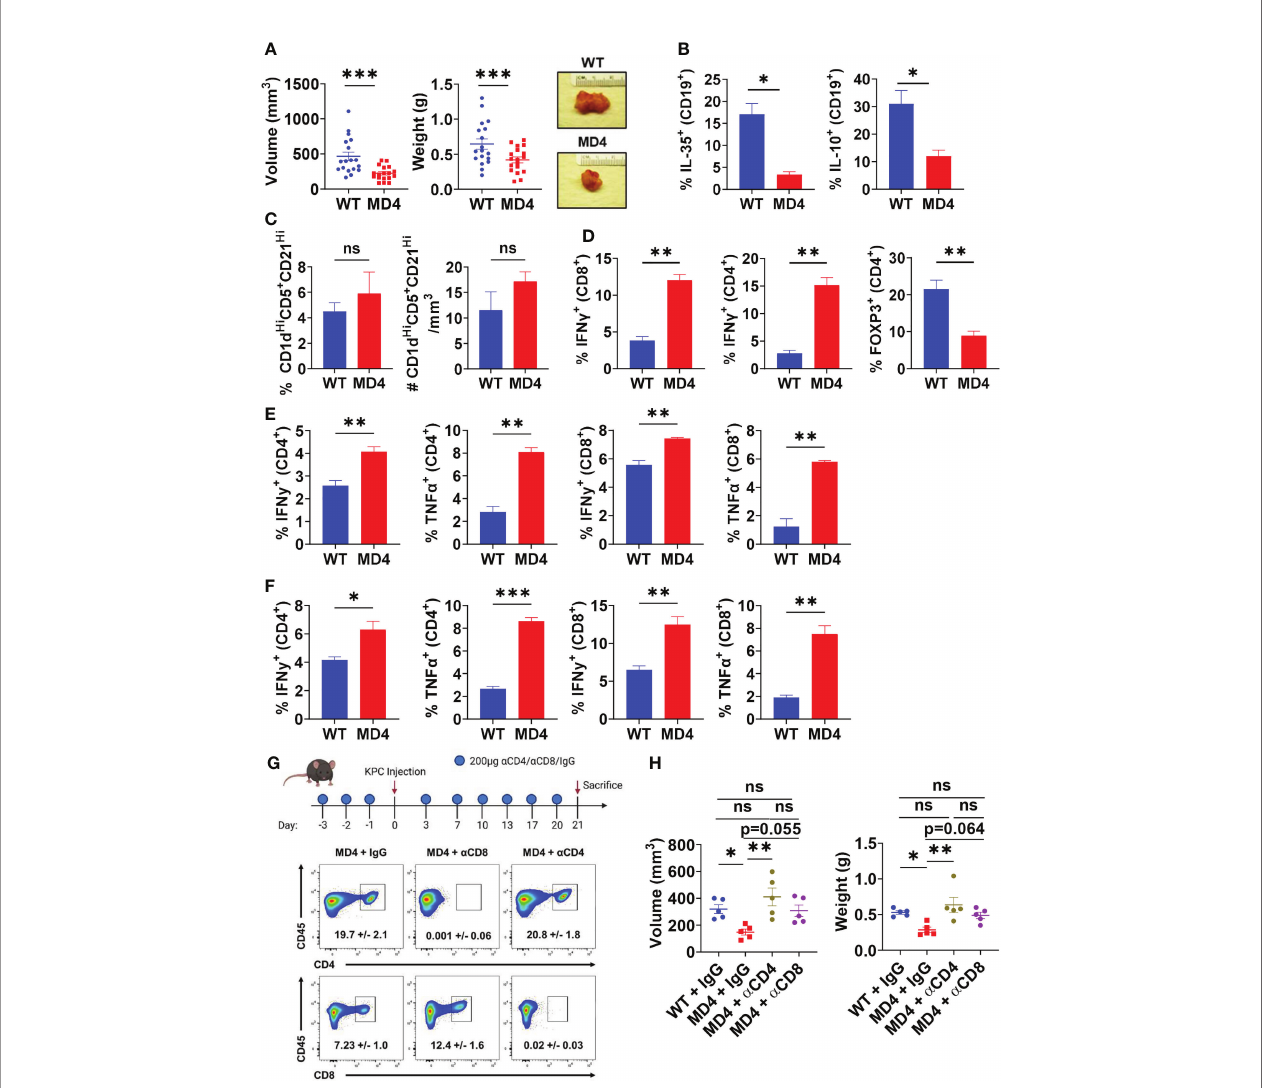
FIGURE 2 | B cell receptor activation promotes pancreatic tumor growth, B cell IL-35 expression, and effector T cell activity. (A) Measured volumes and weights of orthotopic KPC4662 tumors from WT and MD4 mice 21 days post-tumor injection. N=18. (B) Frequencies of IL-35 + (p35 + ) and IL-10 + B cells isolated from WT and MD4 KPC4662 orthotopic tumors at day 21 post-tumor injection. N=3. (C) Frequency (left) and number (right) of CD19 + CD21 Hi CD1d Hi CD5 + B cells isolated from WT and MD4 KPC4662 orthotopic tumors at day 21 post-tumor injection. N=6. (D) Frequencies of and Foxp3 + and IFN g + CD4 + or CD8 + T cells isolated from KPC4662 orthotopic tumors of WT and MD4 tumor-bearing mice at day 21 post-tumor injection. N=3. (E) Frequencies of IFN g + and TNF a + CD4 + or CD8 + T cells isolated from spleens of WT and MD4 KPC4662 orthotopic tumor-bearing mice at day 21 post-injection. N=3. (F) Frequencies of IFN g + and TNF a + CD4 + or CD8 + T cells isolated from tumor-draining lymph nodes (TdLN) of WT and MD4 KPC4662 orthotopic tumor-bearing mice at day 21 post-injection. N=3. (G) Schematic of T cell depletion in MD4 mice with KPC4662 orthotopic tumors and representative fl ow cytometry plots of CD45 + splenocytes isolated at day 21 post-tumor injection. (H) Measured volumes and weights of orthotopic KPC4662 tumors from WT and MD4 mice with or without CD4 + or CD8 + T cell depletion 21 days post-tumor injection. N=5. Error bars indicate SEM; p values in (A – F) were calculated using unpaired t-test; p values in (H) were calculated using one-way ANOVA. NS, non-signi fi cant, *p<0.05, **p<0.005, ***p<0.001. Data are representative of three independent experiments. Experiments were performed using 7 – 8-week-old mice of indicated